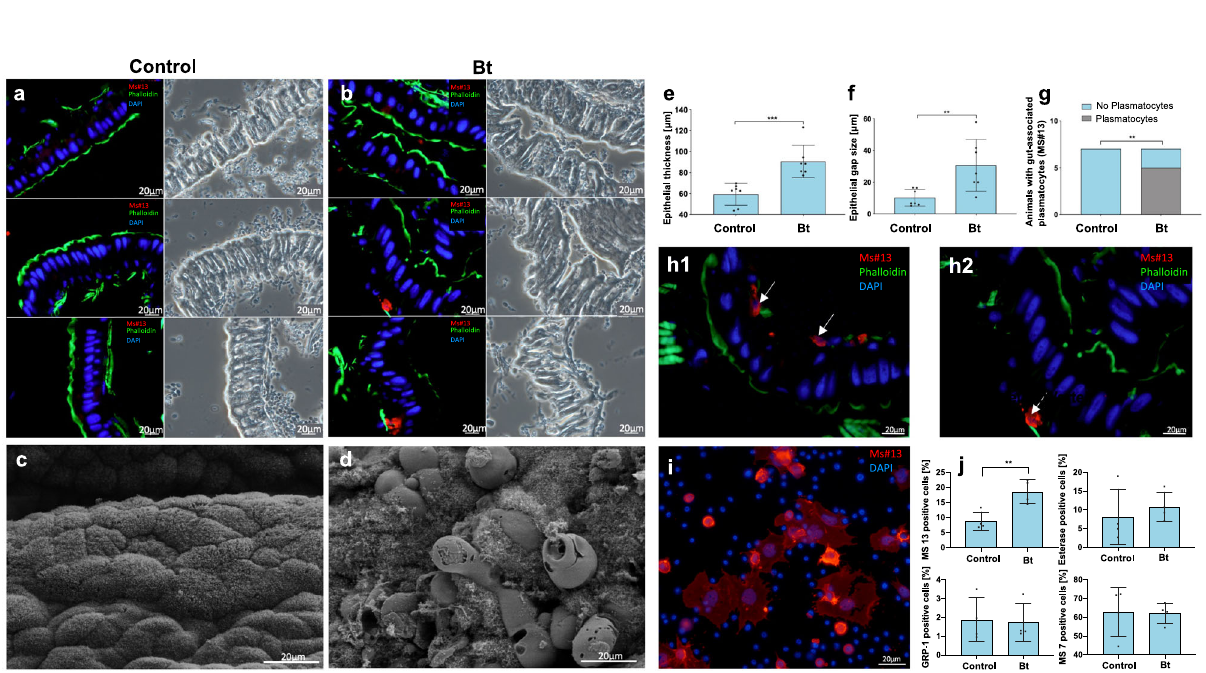
midgut with descriptive statistics. The fat body of M. sexta in μ MRI with ( f ) and without ( e ) fat suppression. The difference between e and f is shown in g and correspondstothefatbodyof M.sexta ( h ). i Showsanaxialparaf fi nsection(L5d2), which shows the fat body and con fi rms our analysis of e and f . j This shows a corresponding axial μ MRI of an M. sexta (L5d5) larvae. Bar charts represent mean and SD. Every data point represents a single animal. Source data are provided as a Source Data fi le.